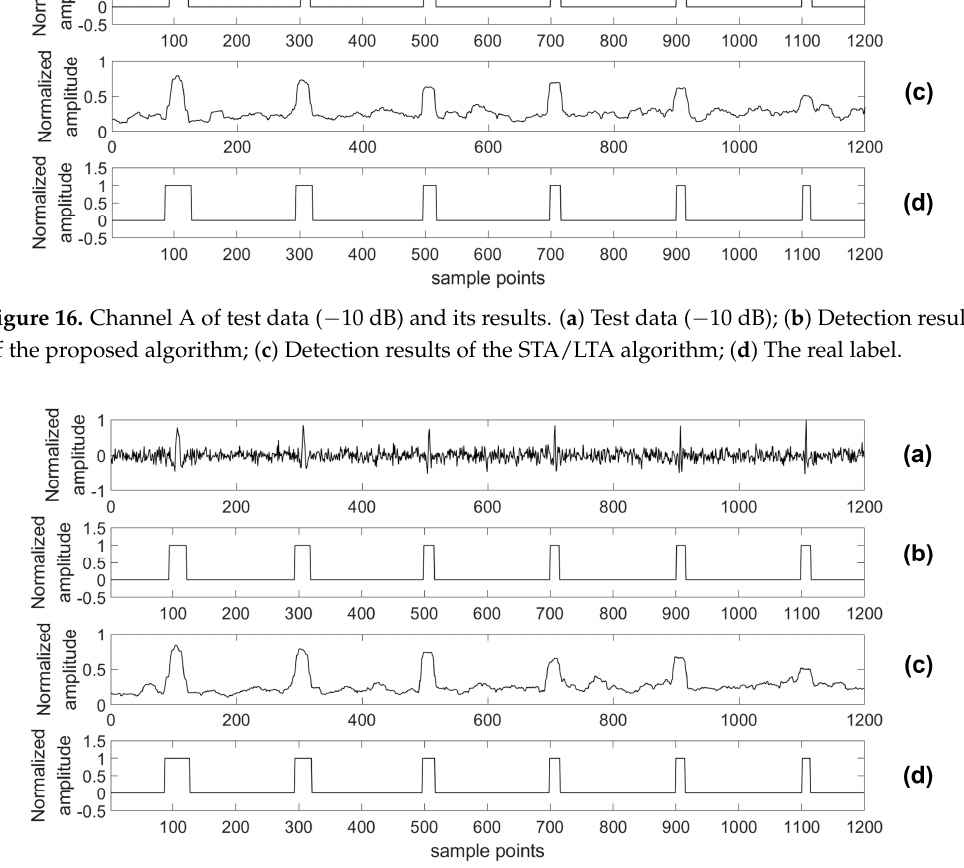
Figure 17. Channel B of test data ( − 10 dB) and its results. ( a ) Test data ( − 10 dB); ( b ) Detection results of the proposed algorithm; ( c ) Detection results of the STA/LTA algorithm; ( d ) The real label.